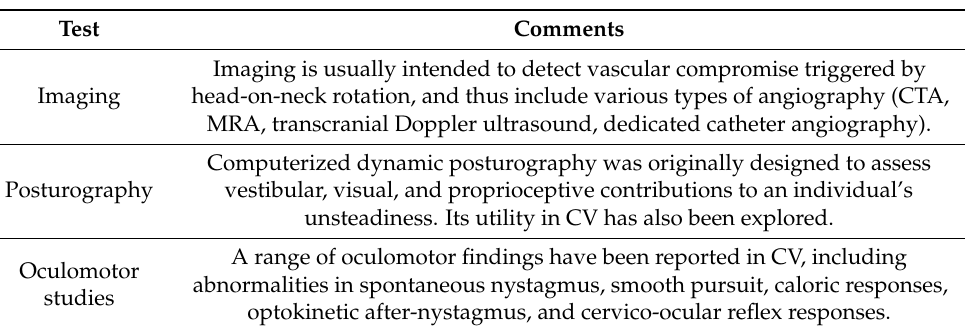
Table 2. A selection of tests intended to help diagnose